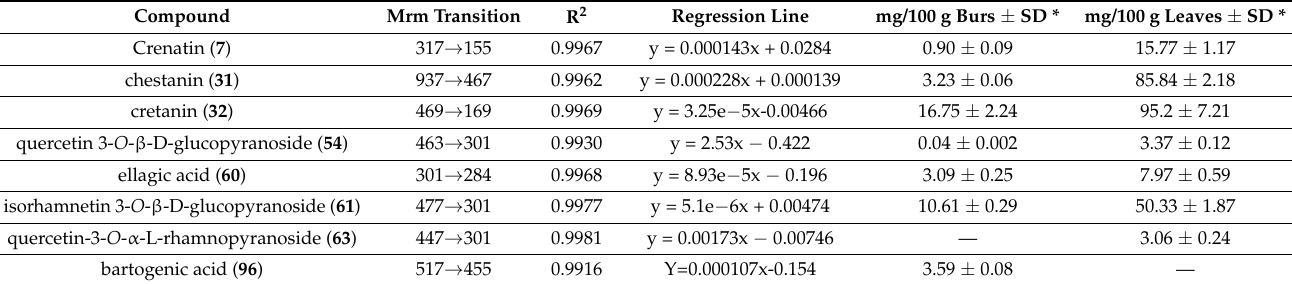
Table 5. Quantitative results of phenolic compounds occurring in MeOH extract of C. sativa (Marrone di Roccadaspide) burs and leaves. Compound Mrm Transition R 2 Regression